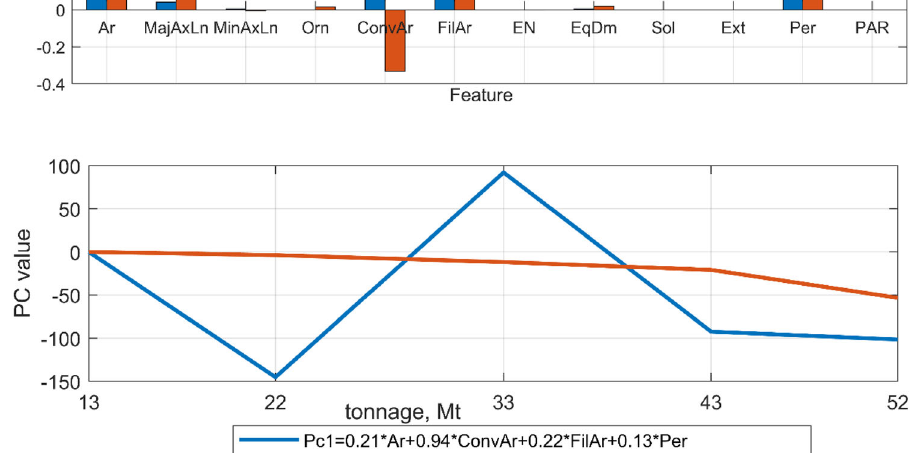
Fig. 13 The mean Pc1 and Pc2 values versus the frog’s